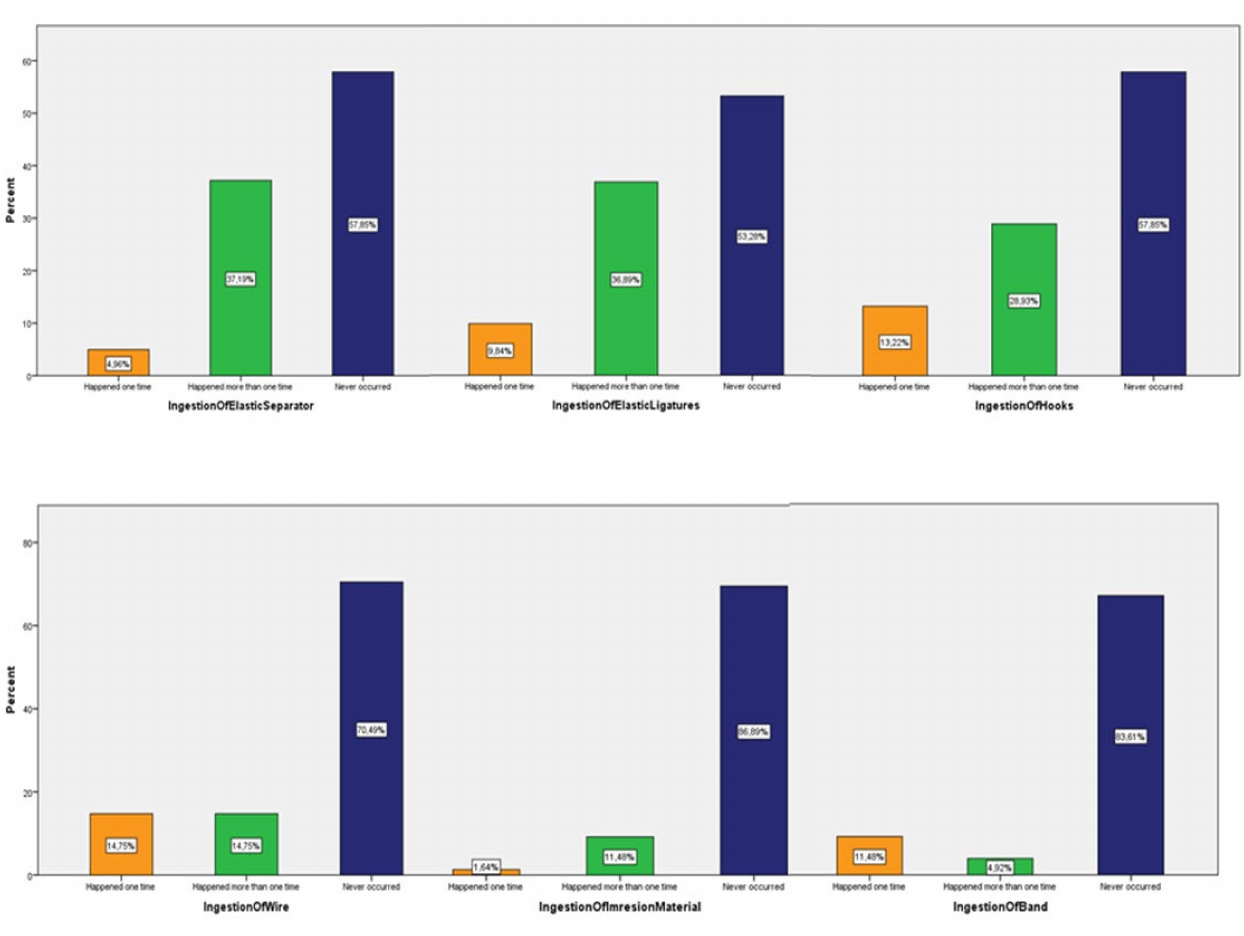
Figure 4. Multiple linear regression for the potential correlation of the factors under investigation with years of practice/experience.